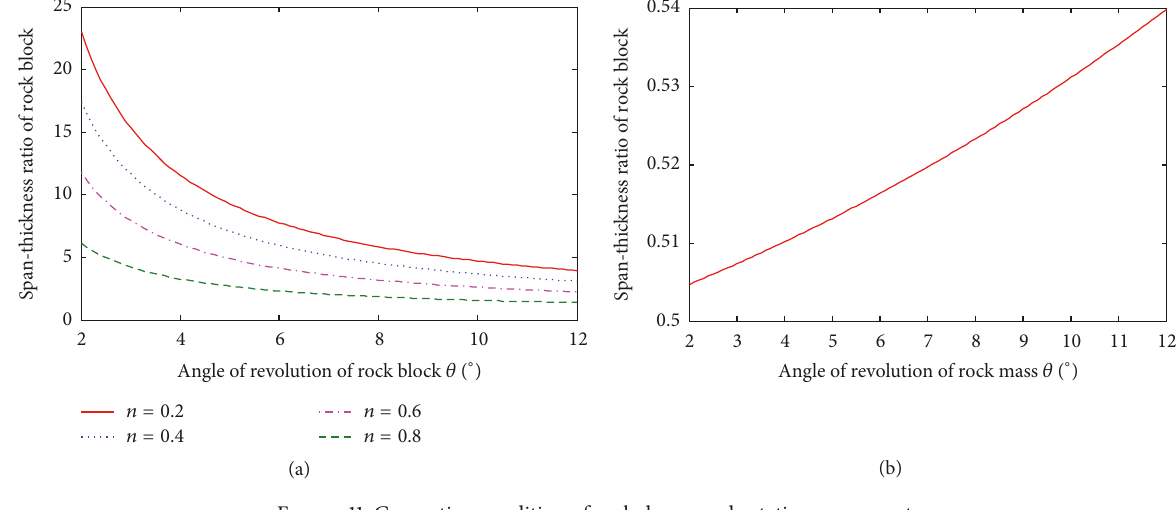
Figure 11: Generating condition of rock downward rotation movement.